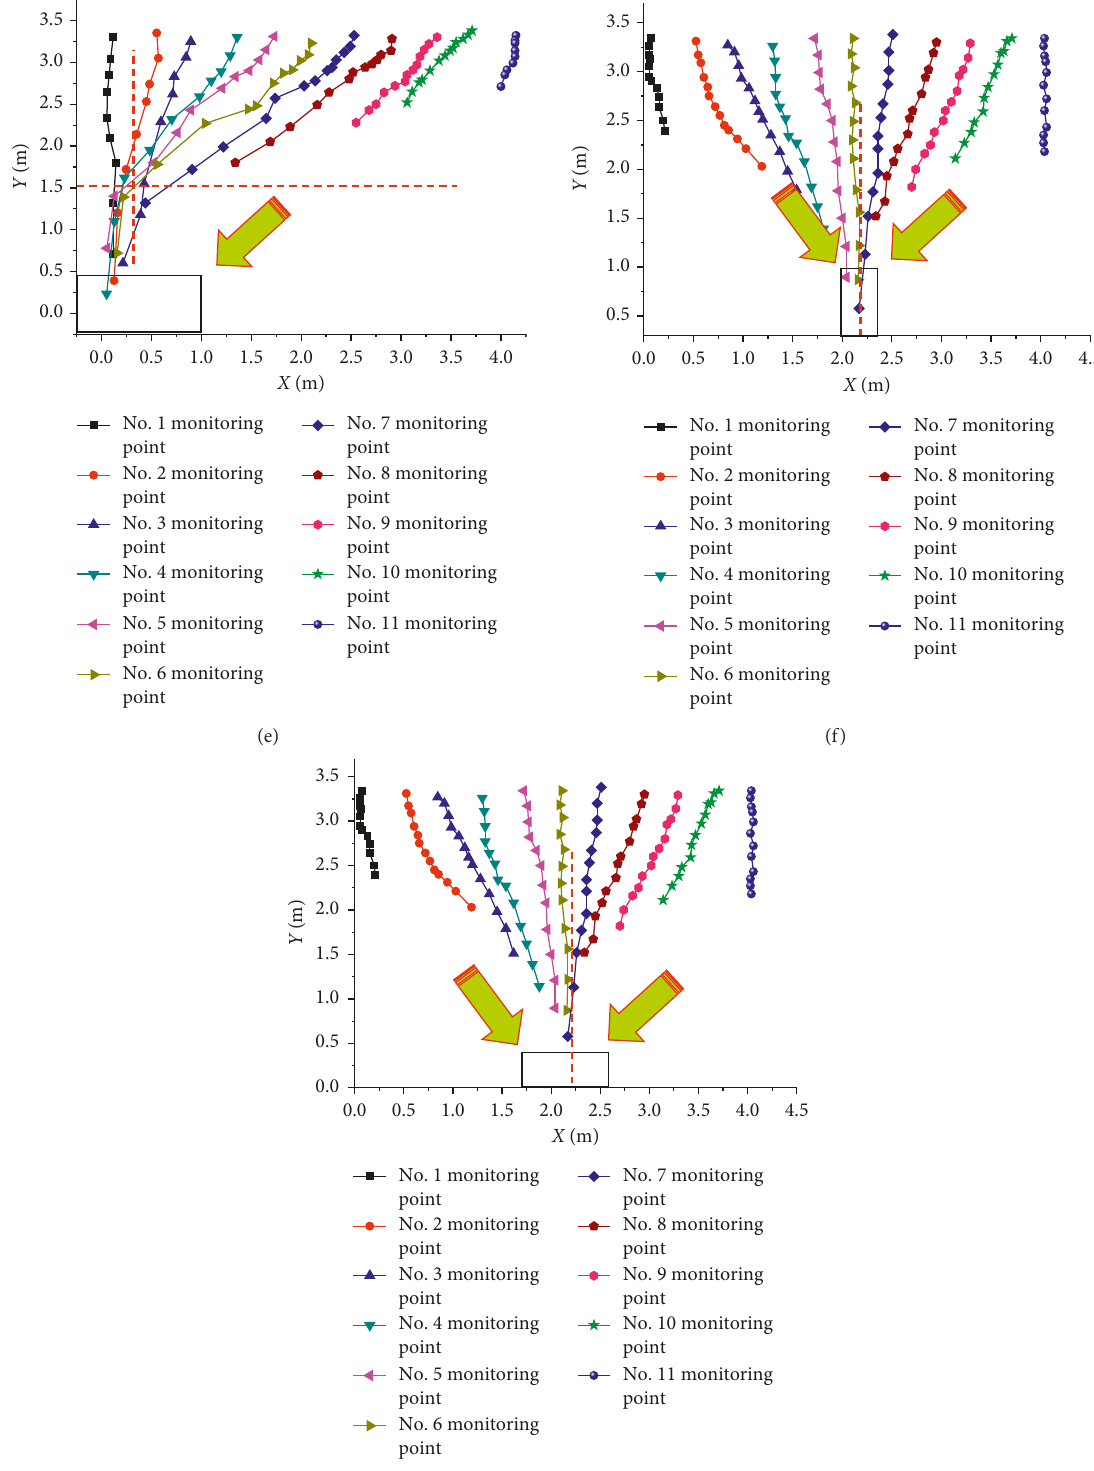
Figure 11: Moving track of coal particle excavation. (a) 0.1 m particle size. (b) 0.2m particle size. (c) 0.1–0.2m particle size. (d) 1 m × 0.5m excavation. (e) 0.5m × 1m excavation. (f) 1 m × 0.5m excavation. (g) 0.5 m × 1m